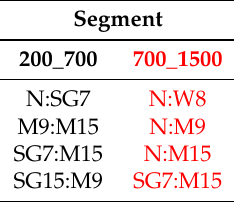
Table 3. Time series, between which significant differences in the LLE values were not exposed (200–700 ms)—on the left and those for which significant differences were confirmed (700–1500 ms)—on the